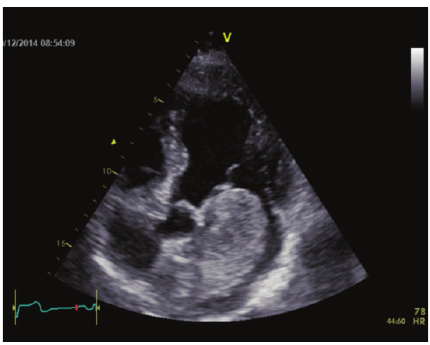
Figure 1: Transthoracic echocardiography shows the giant left atrial myxoma protruding through the mitral valve into the left ventricle during diastole.